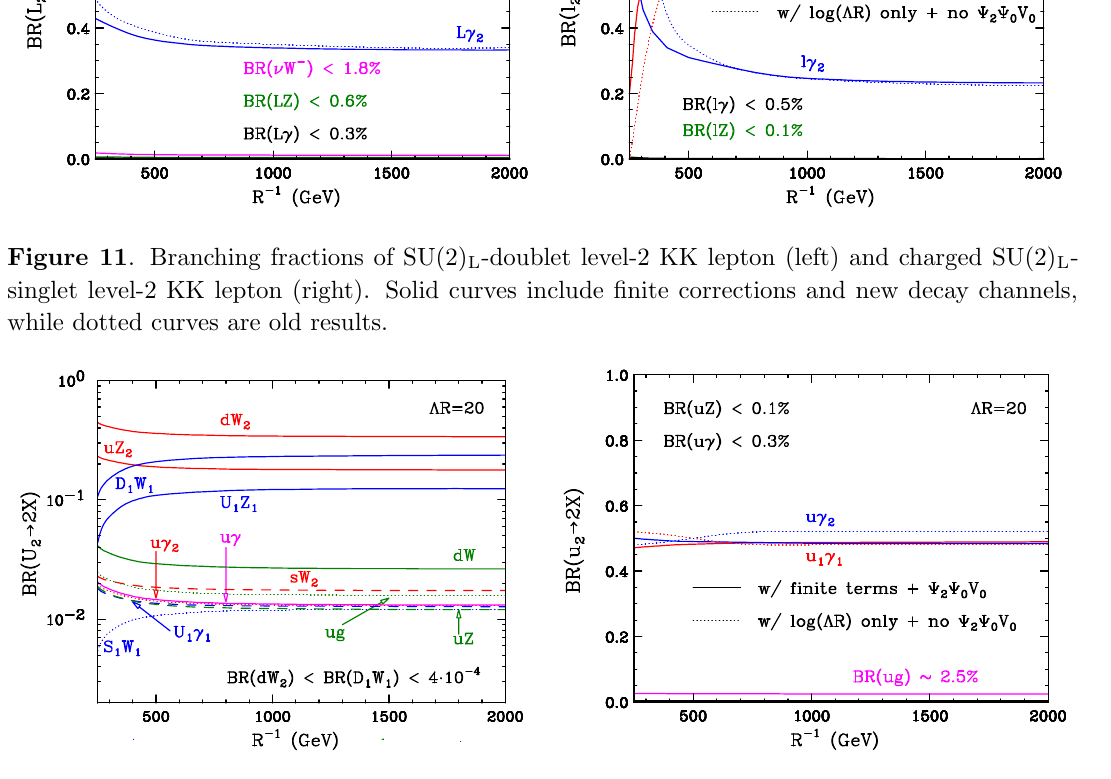
Figure 12 . Branching fraction of SU(2) L -doublet level-2 KK quark (left) and SU(2) L -singlet level-2 KK quark (right) for the